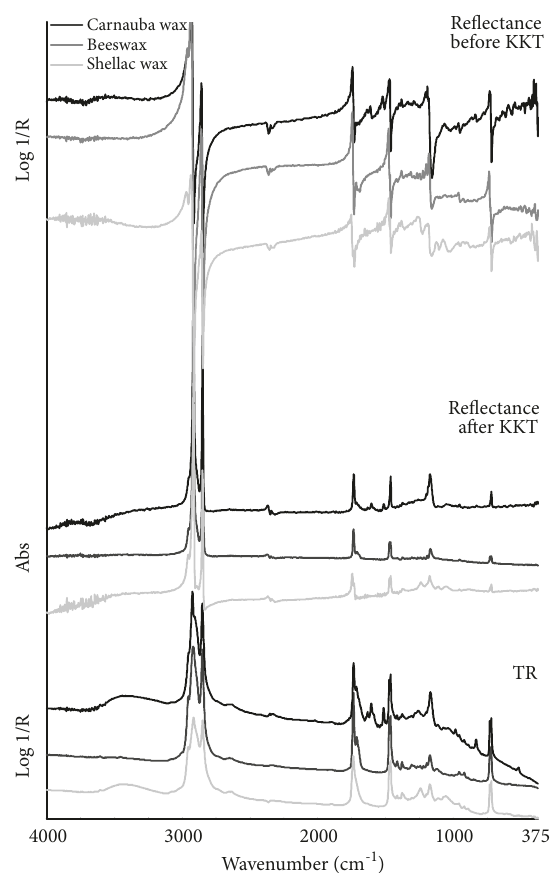
Figure 3: FTIR spectra in the mid-infrared region of the studied lipid materials (black line: carnauba wax, gray line: beeswax, light gray line: shellac wax) using different analysis modes. From top to bottom: total reflection mode before the KKT correction, total reflection mode after the KKT correction, and transflection